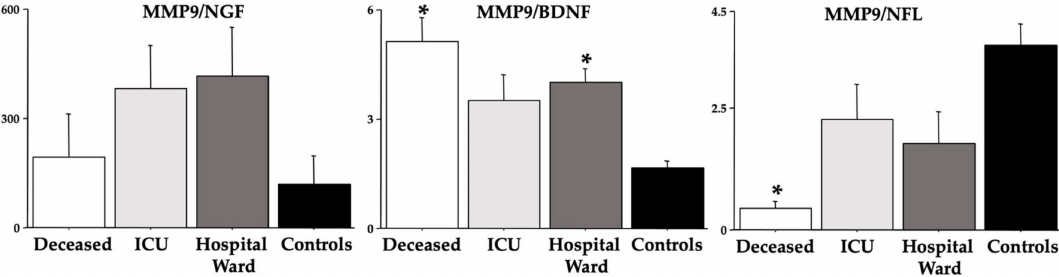
Figure 6. MMP-9 ratios vs. NGF, BDNF, and NFL in COVID-19 patients. The error bars indicate pooled standard error means (SEM) derived from the appropriate error mean square in the ANOVA. The asterisk ( p < 0.05) indicates post hoc differences with controls.